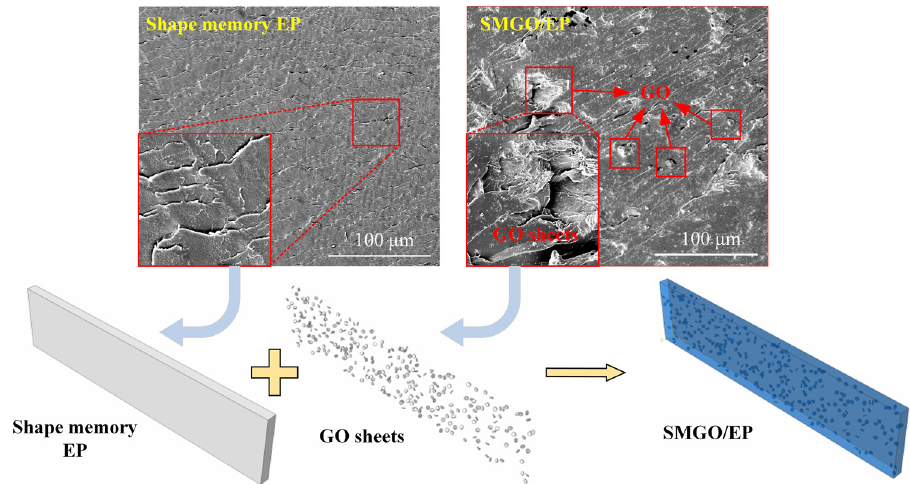
Figure 5: Micro modeling of SMGO/EP composites.